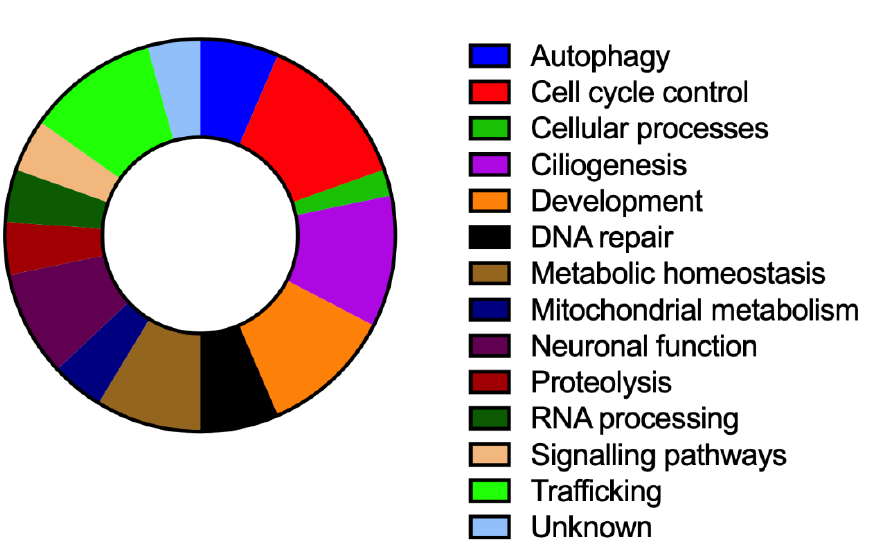
Figure 2. Main functions of genes related to recessive ataxias.